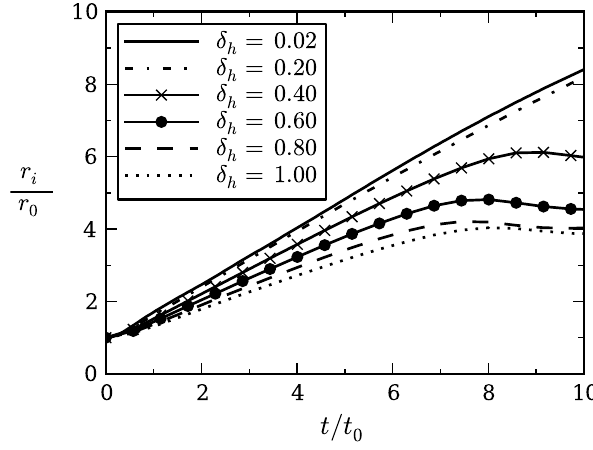
Fig. 4. The location of the intrusion front versus time for simulations with ρ =1.0530g/cm 3 and ¯ ρ(z) given by Eq. (1). At a L thick interface ( δ h ≥ 0 . 60), the intrusion begins to decelerate around 4 r 0 , whereas at a thin interface ( δ h ≤ 0 . 2) the intrusion maintains a constant speed beyond 8 r 0